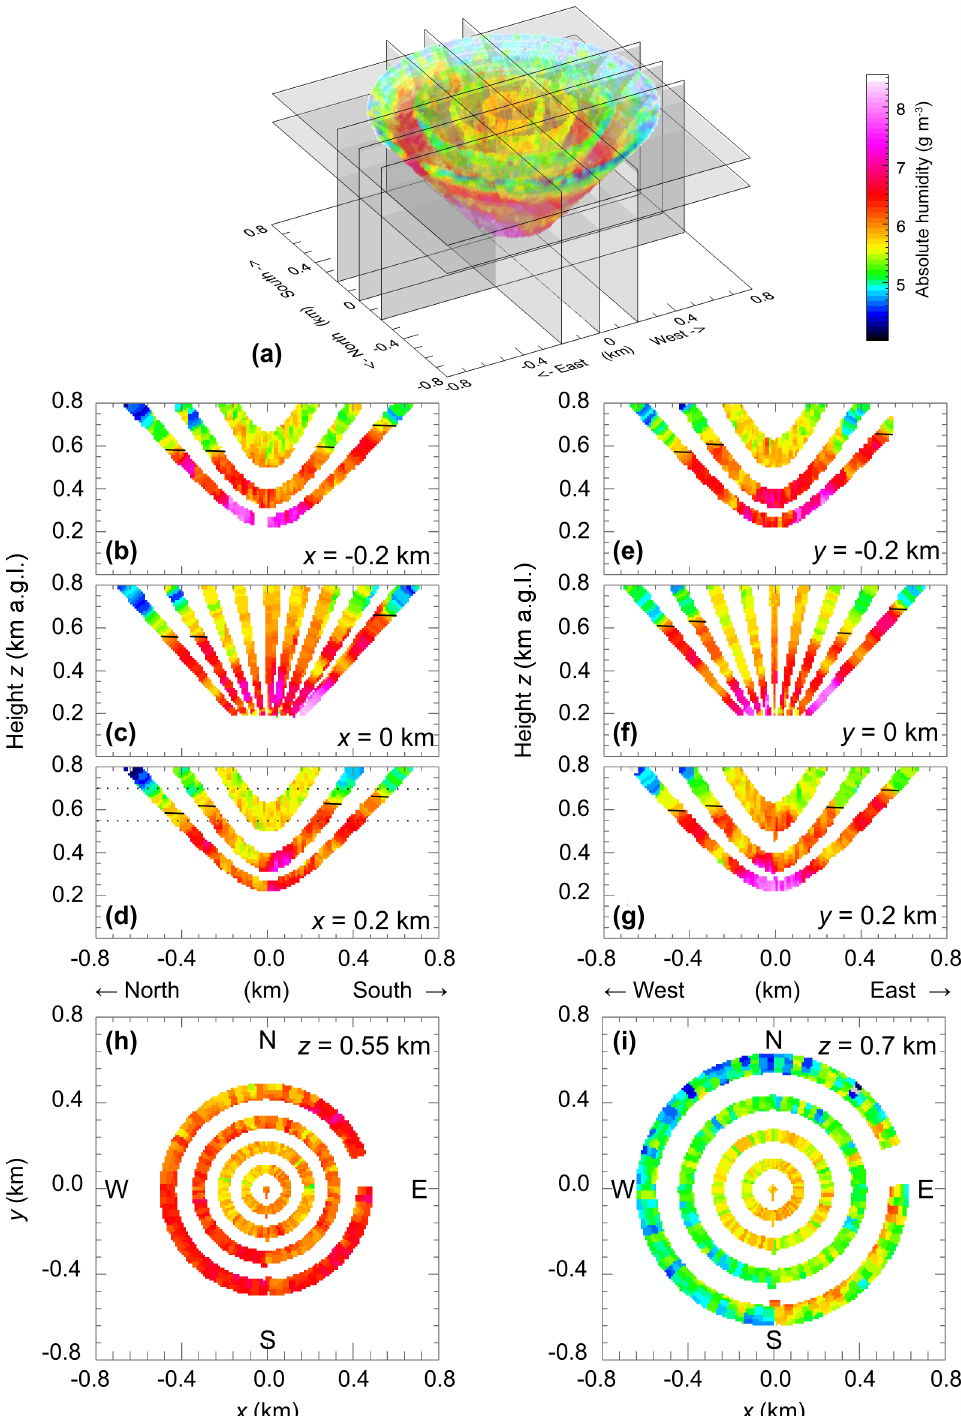
Figure 10. Cutting planes through the 3-D data set provides cross section images. (a) Schematic illustration of the 3-D data set with the cutting planes. (b–i) Horizontal and vertical cross section images of the different cutting plans of (a) . The black lines in (b–g) indicate the top of the boundary layer. The dotted lines in (a) illustrate the location of the horizontal planes (h–i)